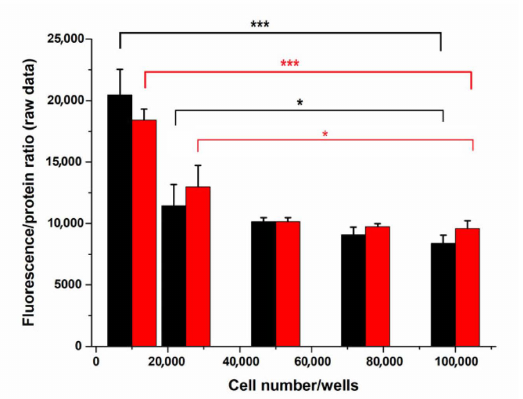
Figure 1. GAPDH expression in control and 10 µ M OTA exposed HepG2 cells at various cell num- ber/well concentrations (raw data as fluorescence/protein ratios). (N = 4). *: p < 0.05, ***: p < 0.001.